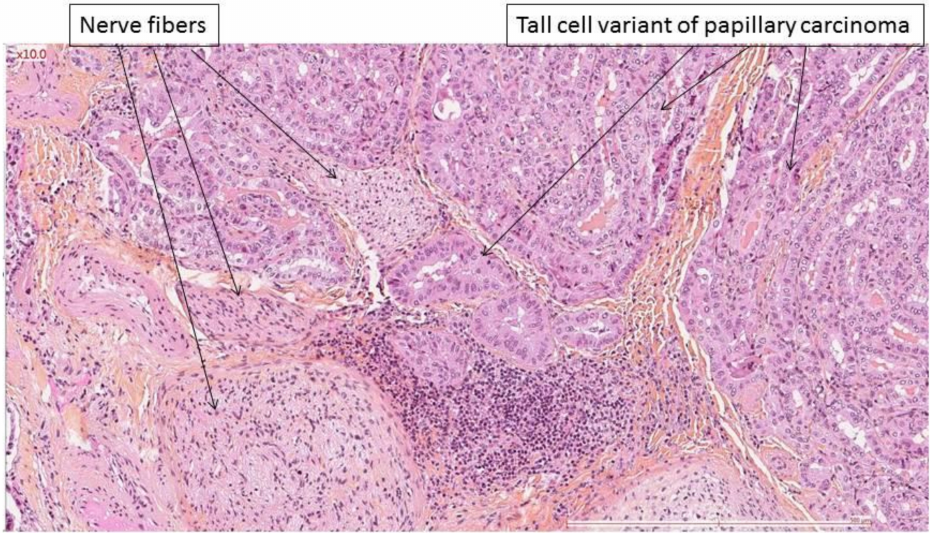
Figure 3. Tall cell variant of papillary thyroid carcinoma invading the nerve, in contact with nerve